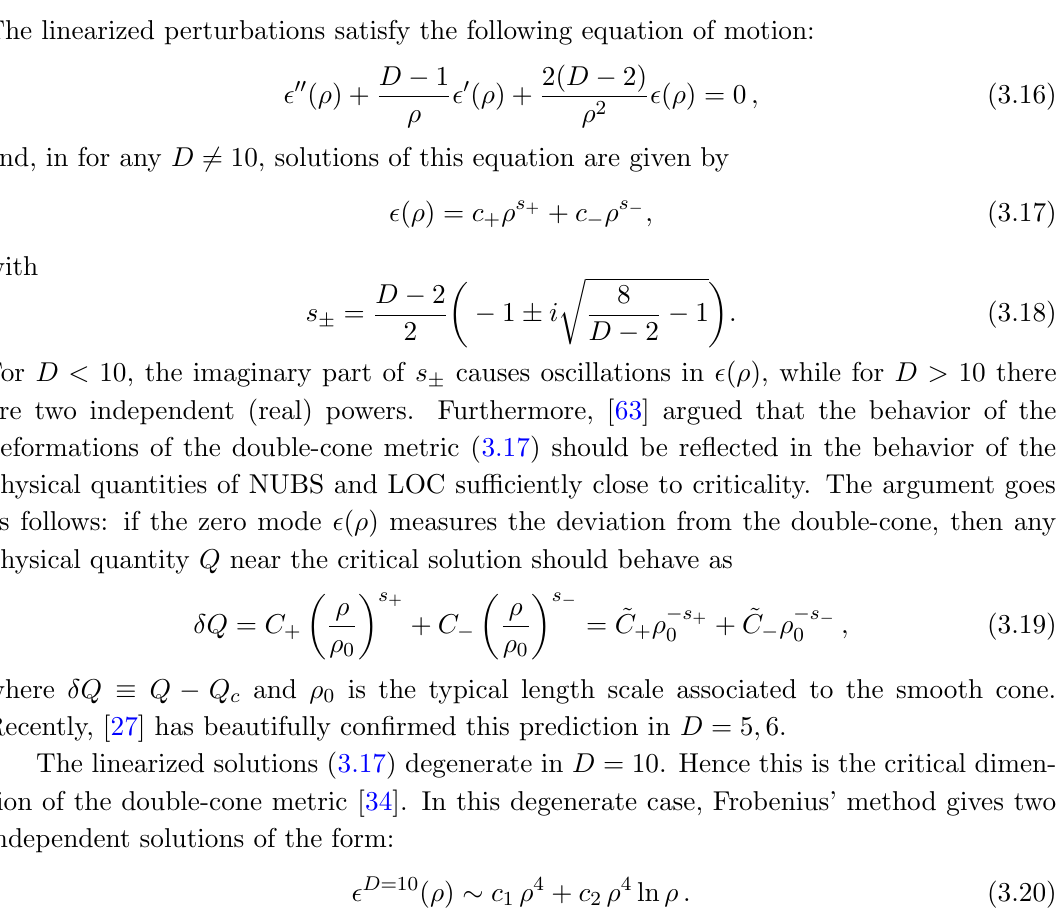
Figure 8 . Comparison between the embeddings into E 9 space of the most critical NUBS (blue line) and LOC (red line) that we have found and the Ricci-(cid:13)at cone (black line). Clearly, both geometries approximate quite well the double-cone